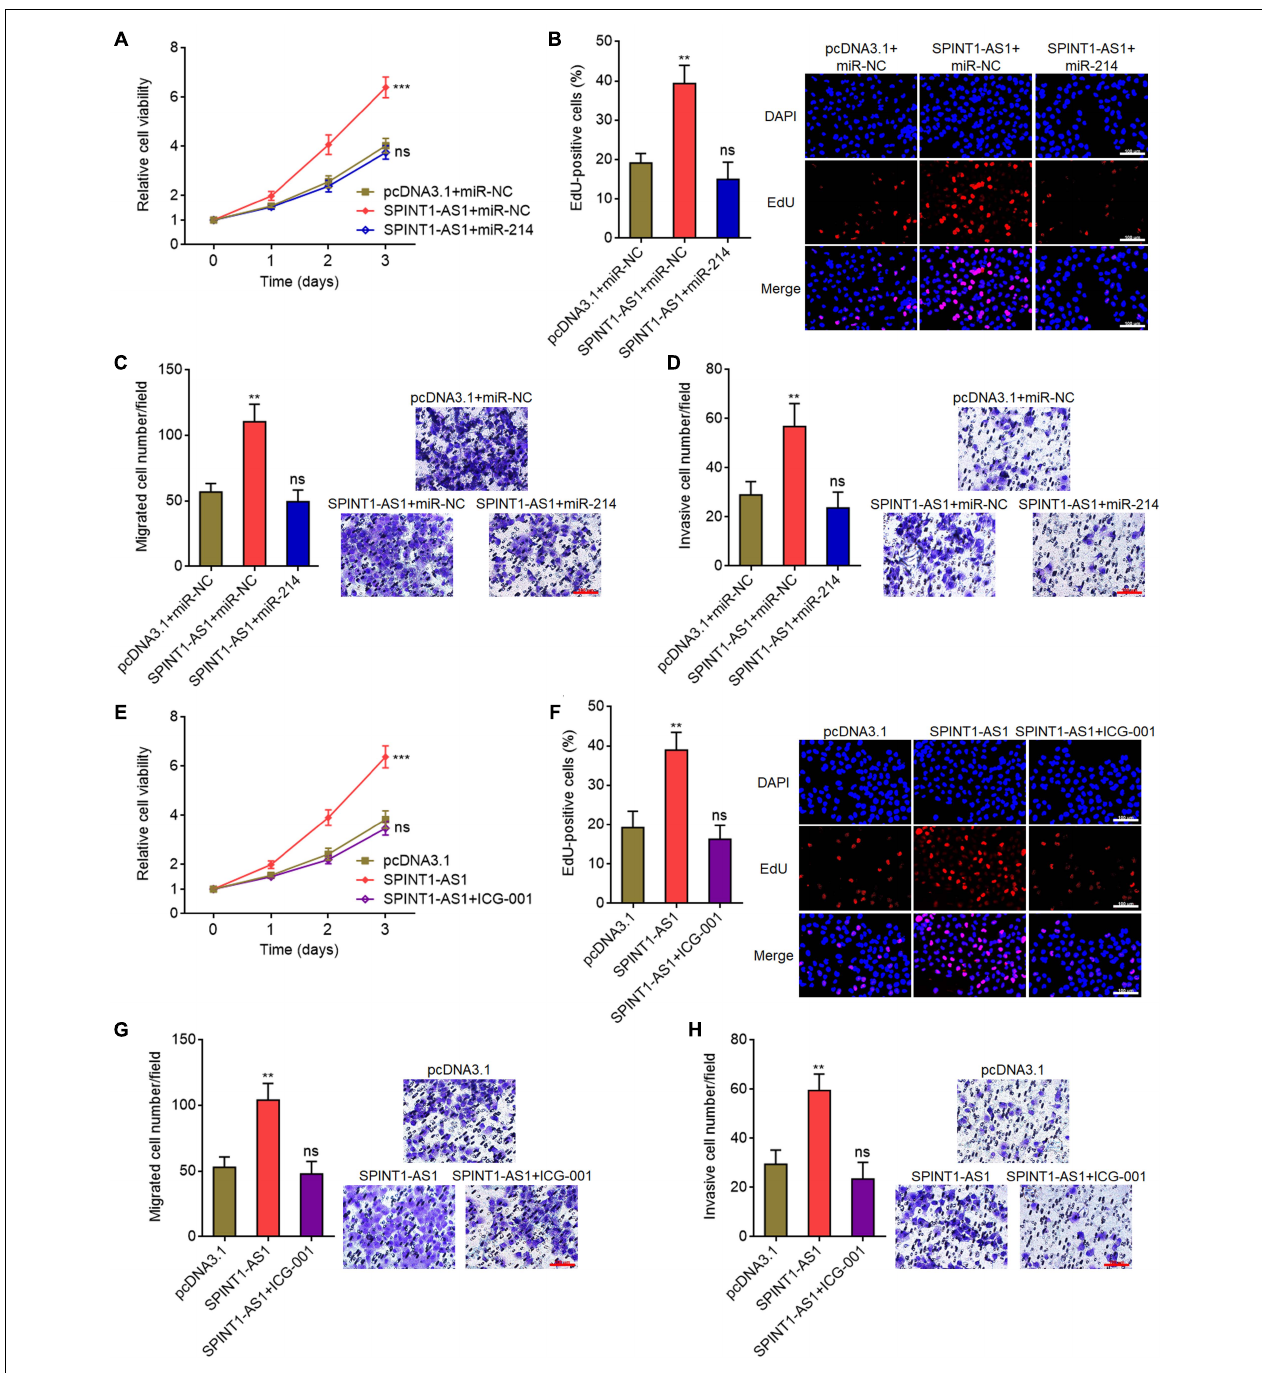
FIGURE 7 | Overexpression of miR-214 or inhibition of Wnt/ β -catenin signaling attenuated the oncogenic roles of SPINT1-AS1 in cervical cancer. (A) Cell viabilities of HeLa cells with SPINT1-AS1 and miR-214 overexpression were detected using Glo cell viability assay. (B) Cell proliferation of HeLa cells with SPINT1-AS1 and miR-214 overexpression was evaluated using EdU staining. Scale bars, 100 µ m. (C) Cell migration of HeLa cells with SPINT1-AS1 and miR-214 overexpression was evaluated using transwell migration assay. Scale bars, 100 µ m. (D) Cell invasion of HeLa cells with SPINT1-AS1 and miR-214 overexpression was detected by transwell invasion assay. Scale bars, 100 µ m. (E) Cell viabilities of HeLa cells with SPINT1-AS1 overexpression after treatment with 20 µ M ICG-001 were detected by Glo cell viability assay. (F) Cell proliferation of HeLa cells with SPINT1-AS1 overexpression after treatment with 20 µ M ICG-001 was evaluated using EdU staining. Scale bars, 100 µ m. (G) Cell migration of HeLa cells with SPINT1-AS1 overexpression after treatment with 20 µ M ICG-001 was evaluated by transwell migration assay. Scale bars, 100 µ m. (H) Cell invasion of HeLa cells with SPINT1-AS1 overexpression after treatment with 20 µ M ICG-001 was detected by transwell invasion assay. Scale bars, 100 µ m. Results are shown as mean ± SD based on three independent experiments. ** P < 0.01, *** P < 0.001, ns, not significant, by one-way ANOVA followed by Dunnett’s multiple comparisons test.